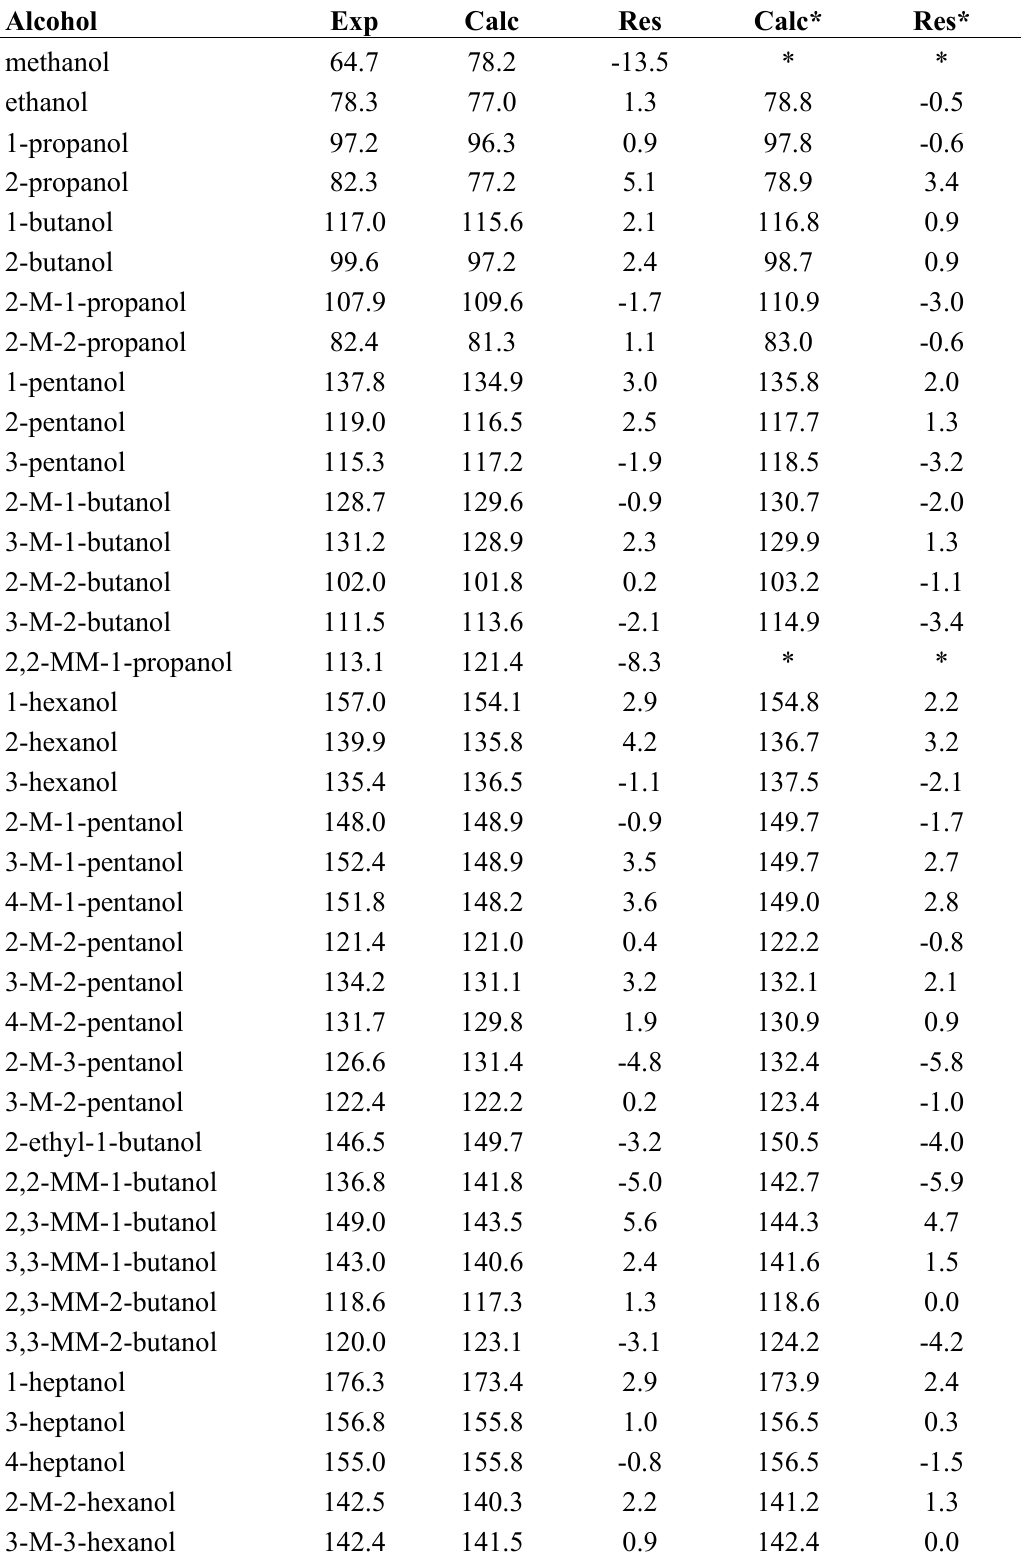
Table 5 . The experimental and calculated normal boiling points for alcohols. The last two columns show results when five outliers have been removed from the set of n = 58